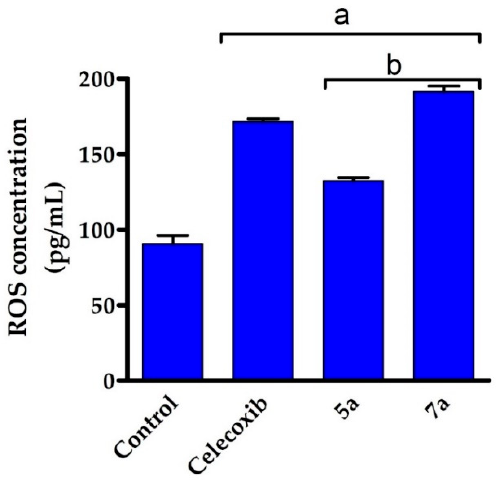
Figure 7. Effect of compounds 5a , 7a , and Celecoxib on the production of ROS (n = 4). Data are presented as mean ± SD. a p < 0.05 versus Control, b p < 0.05 versus Celecoxib.